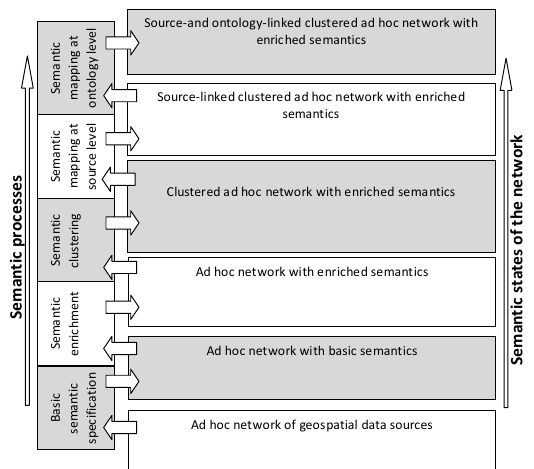
Figure 1. Framework for real time semantic interoperability